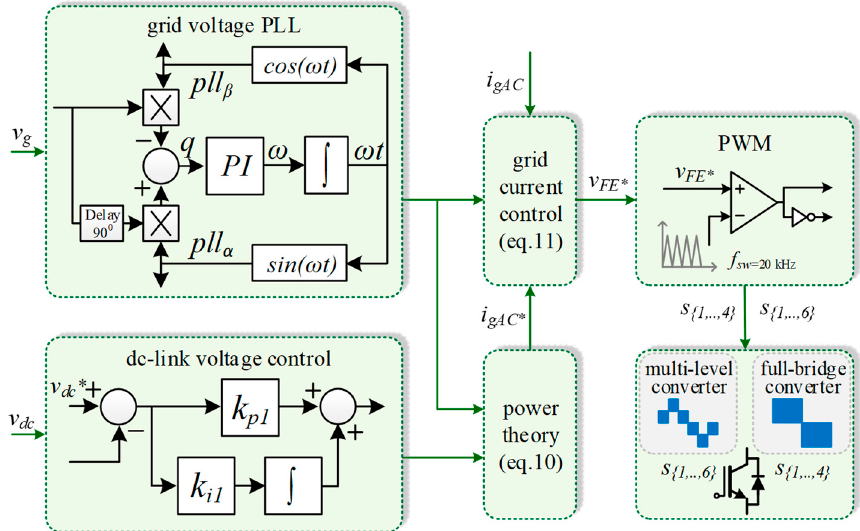
Figure 4. Simplified block diagram of the control system based on the detailed control equations.